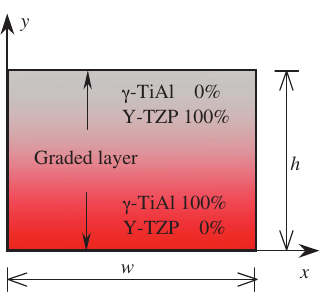
Figure 1: Metal-ceramic